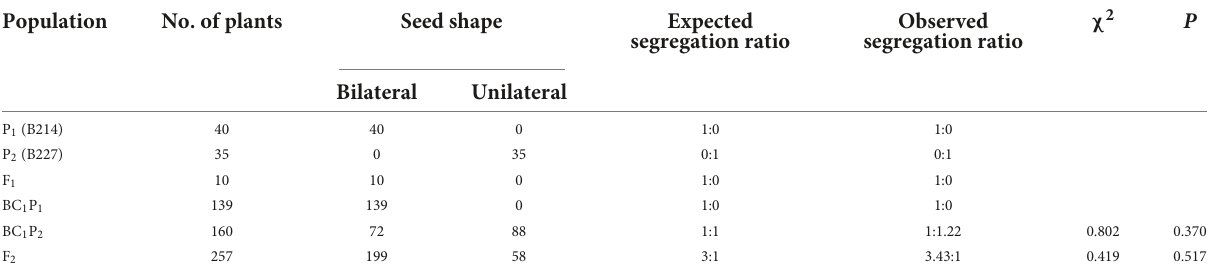
TABLE 1 Segregation of seed shape in wax gourd segregation populations.